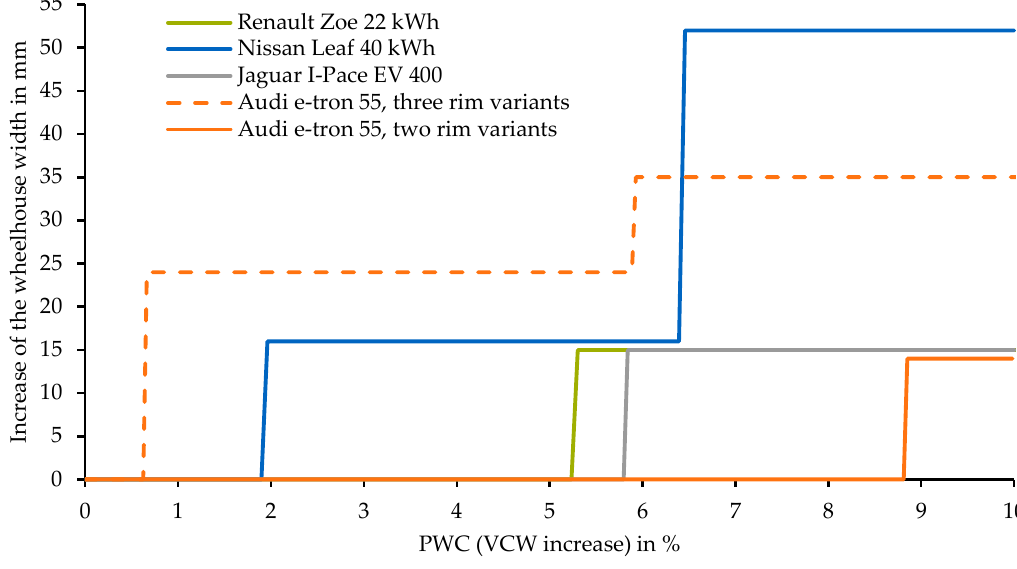
Figure 8. Interdependency between wheelhouse width and PWC.